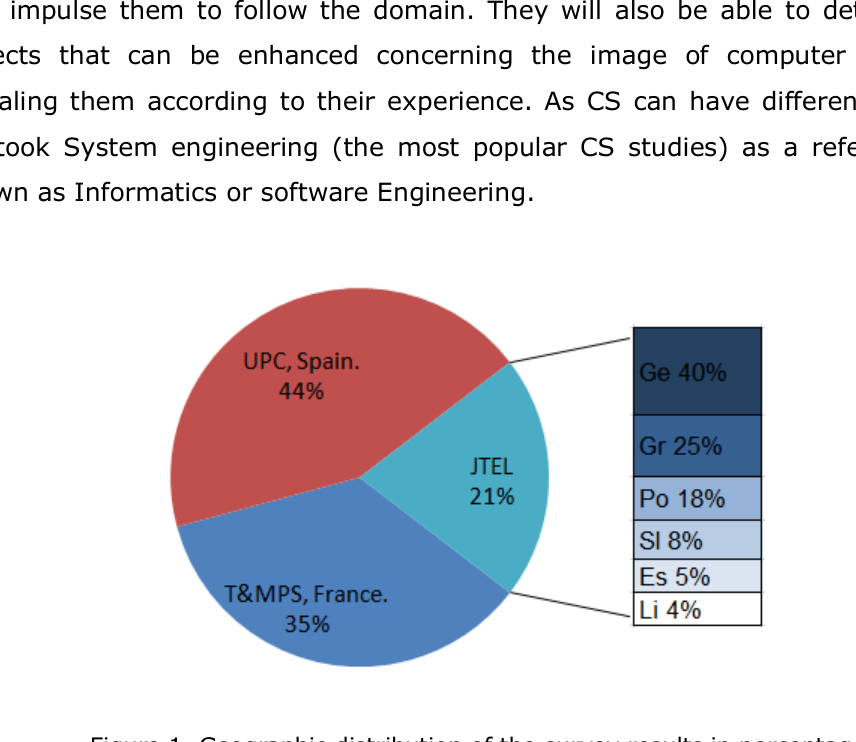
Figure 2 reflects the gender and the professional distribution of the total